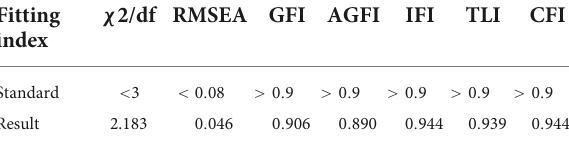
TABLE 9 Structural equation model fitting